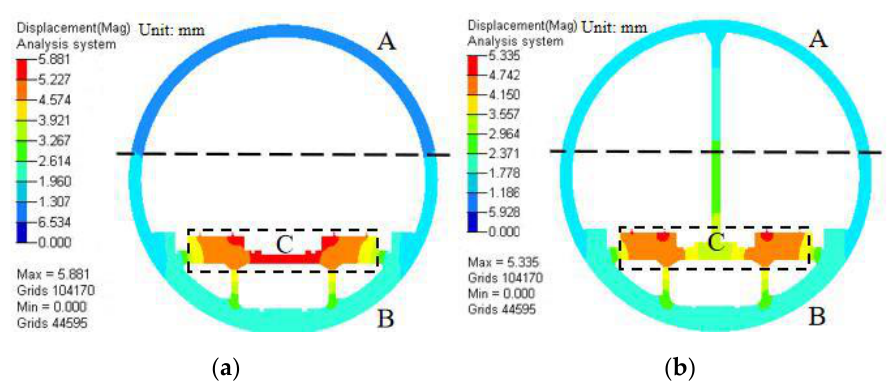
Figure 10. t = 2.45 s, tunnel displacement response during double-train traffic: ( a ) double-track tunnel; ( b ) double-track tunnel with middle partition wall; zone A is the upper half of the tunnel, zone B is the lower half of the tunnel, zone C is the track bed and surrounding connections.